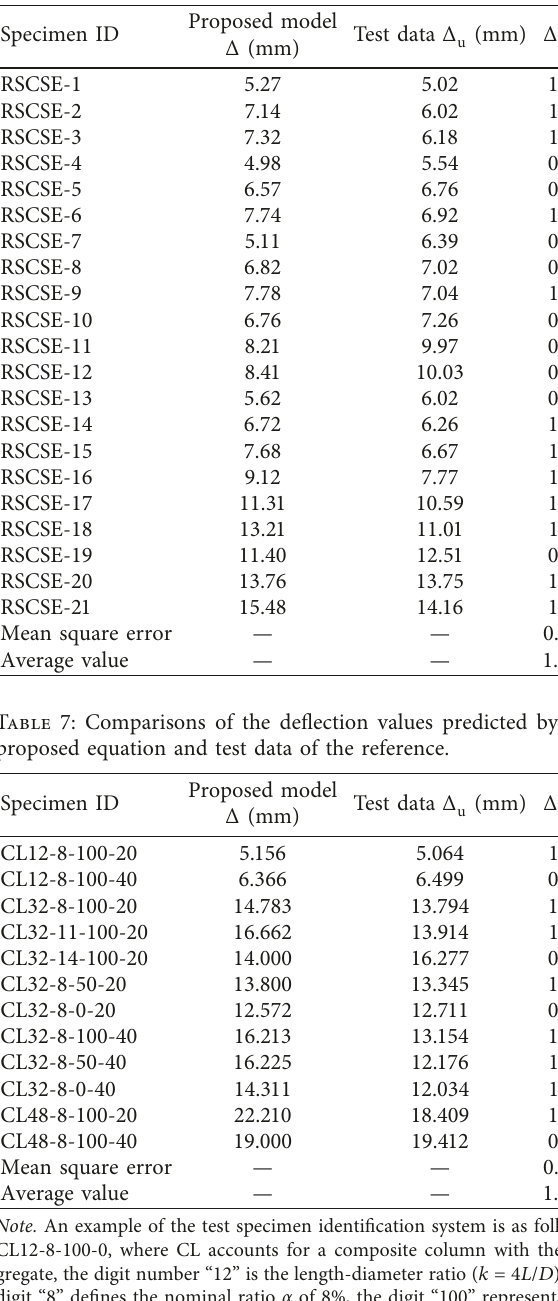
Table 6: Comparisons of the deflection values predicted by the proposed equation and test data of this study.